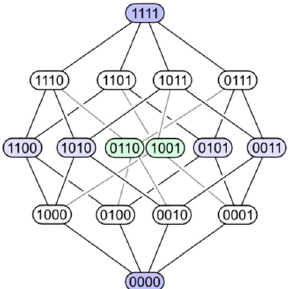
Figure 2. Hypercube by Tilman Piesk (Public Domain).